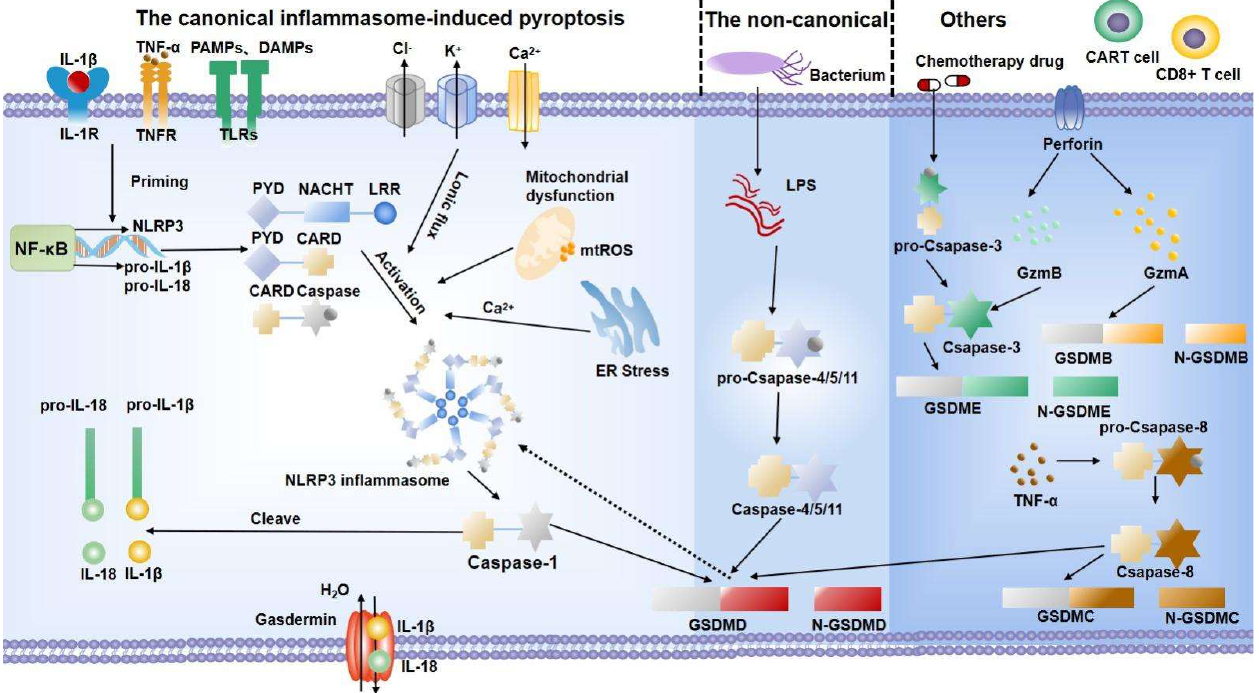
Figure 1. Pyroptosis pathway. The canonical inflammasome-induced pyroptosis pathway (taken NLRP3 inflammasome pathway) begins with the interaction between receptors and ligands. Then, the NF-κB signal is activated and increases the expression of the NLRP3 inflammasome. Meanwhile, activation signals, including various disturbances, improve the assembly of the NLRP3 inflammasome. Then, the assembled NLPR3 activates caspase-1 to mature IL-18 and IL-1β. The noncanonical inflammasome-induced pyroptosis is mediated by LPS to activate caspase-4/5/11 to cleave GSDMD. In other ways, different cells activate the gasdermin family through caspase-dependent or caspase-independent pathways, which eventually lead to cell expansion, membrane perforation, and the release of cytoplasmic content. IL: interleukin; TNF-α: tumor necrosis factor-α; PAMPs: pathogen-associated molecular patterns; DAMPs: damage-associated molecular patterns; TLRs: